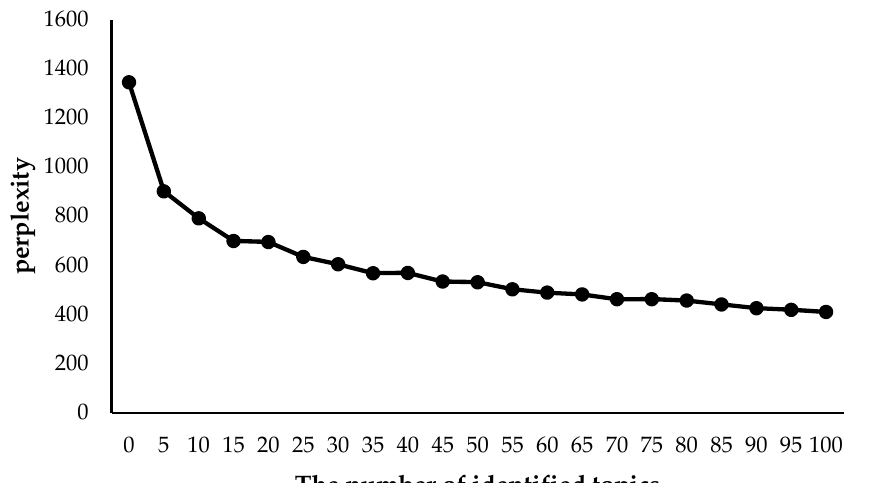
Figure 2. The perplexity of the Sent-LDA model with a topic number in the range [0, 100]. Bao and Datta [34] used the manual labeling procedure designed by Huang and Li [33] to label different topics of risk factors. Thus, we also use the manual labeling procedure